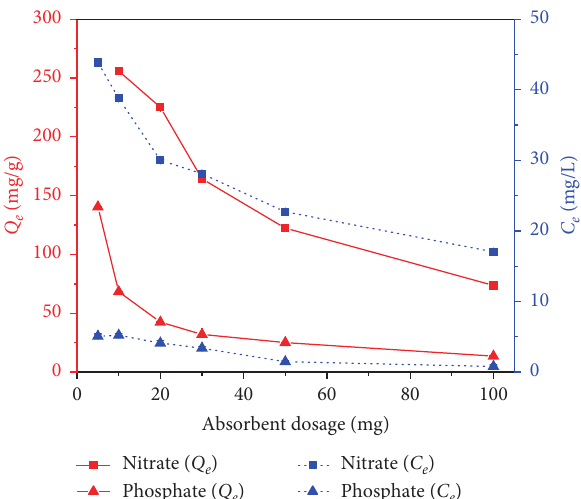
Figure 9: Remaining concentration and adsorption capacity of nitrate and phosphate at different adsorbent dosages.